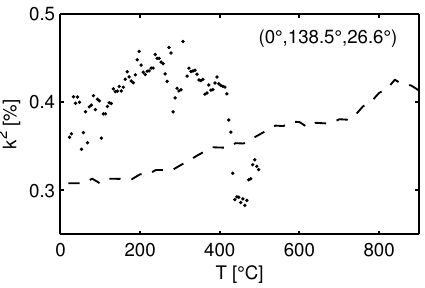
Figure 11. Coupling coefficient k 2 for Rayleigh waves on cut (0, 138.5, 26.6 ◦ ), calculated with tensor data from BAW measurements (dashed lines) and extracted from SAW measurements (points).